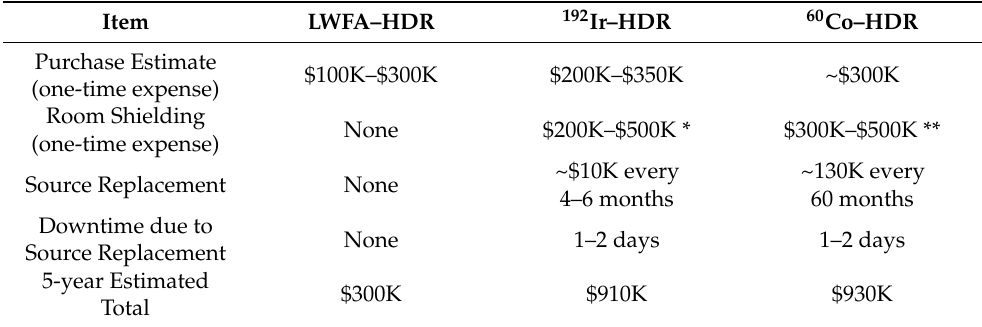
Table 1. Estimated purchase and maintenance cost comparisons for LWFA-HDR and conventional HDR